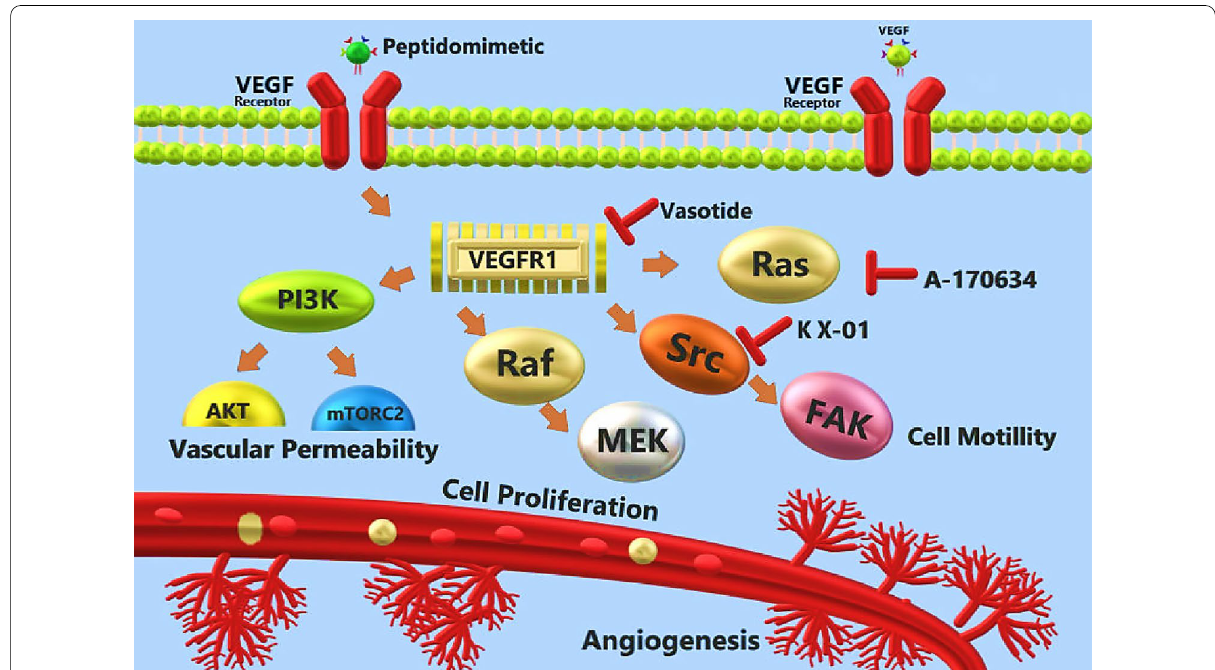
Fig. 2 Implementation of peptidomimetics against tumor